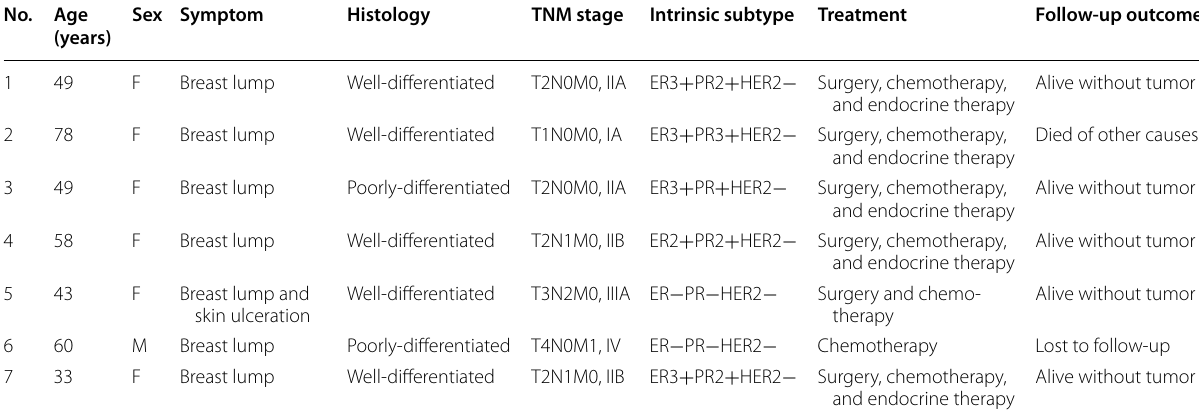
These patients were diagnosed and treated at the National Cancer Center/Cancer Hospital, Chinese Academy of Medical Sciences and Peking Union Medical College, China F female, M male, ER estrogen receptor, PR progesterone receptor, HER2 human epidermal growth factor receptor 2